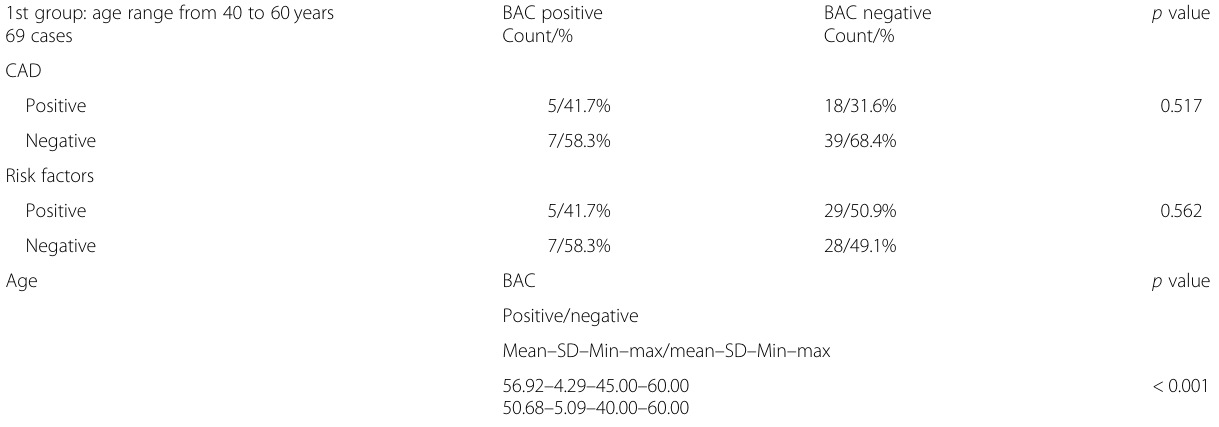
Table 3 Relation of BAC in 1st group (40 to 60 years) with age, cardiac conditions, and risk factors 1st group: age range from 40 to 60 years 69 cases